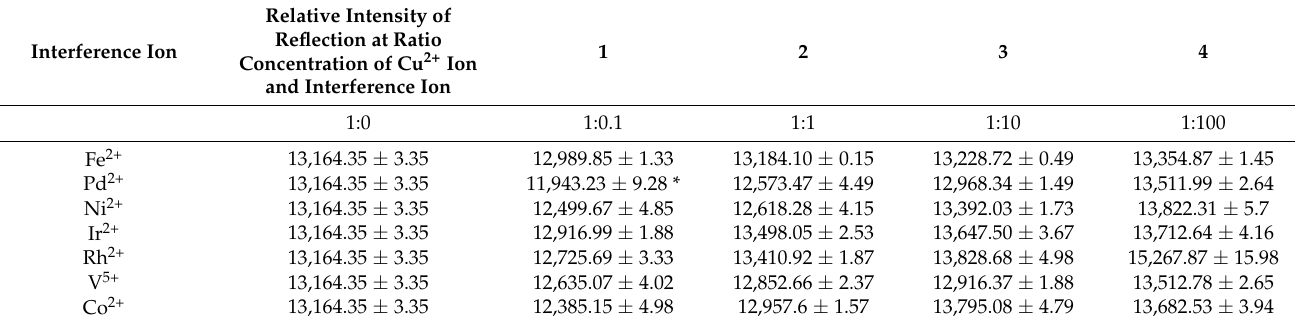
Table 1. The relative reflectance intensities obtained by the constructed optical sensor in detection of 1 × 10 − 5 M of Cu 2+ ion in the absence and presence of potential interfering ions at pH 6 and wavelength of 631.1 nm ( n =